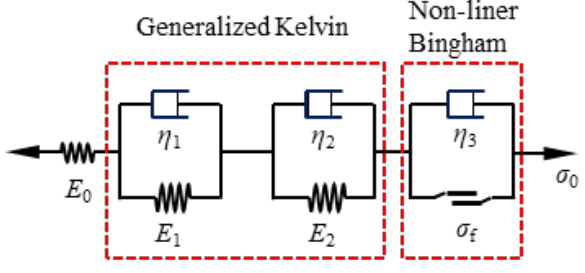
Figure 3. One-dimensional Komamura-Huang-Bingham